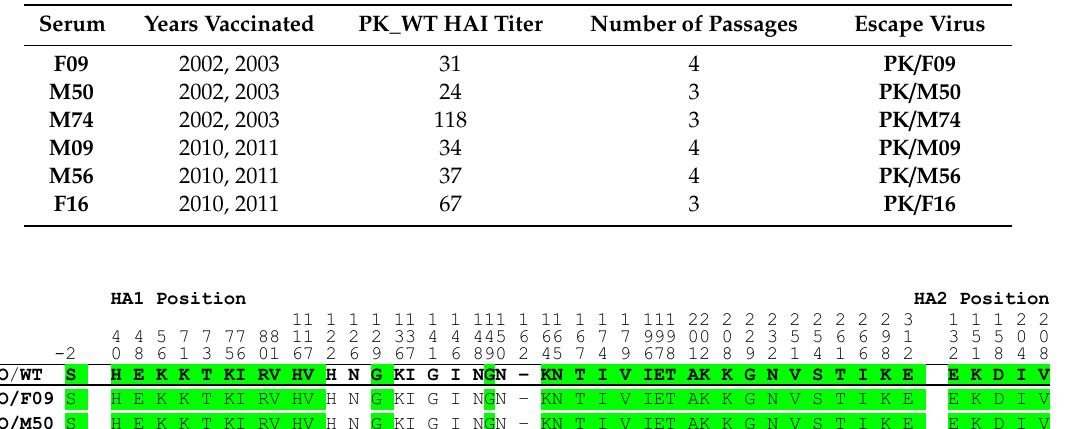
Table 2. Serum and Yamagata lineage virus. The designation for each post-vaccination serum (column 1) and year of vaccine receipt (column 2) are listed. HAI titers, the geometric mean from four replicates, toward the contemporary PK_WT (B / Phuket / 3073 / 2013) virus are shown in column 3. The number of passages used to attain the escape virus and the name of each virus, which incorporates the serum name, are shown in the last two columns.